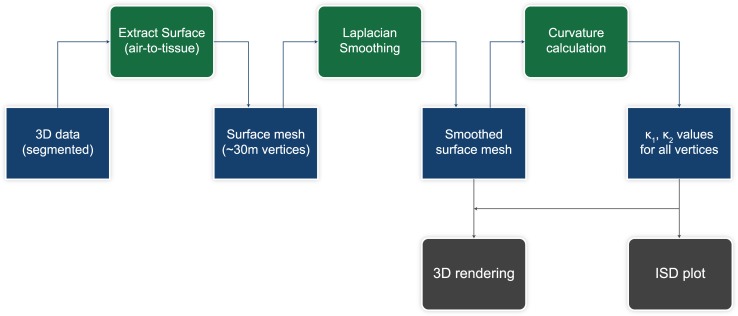
Curvature analysis flowchart.Processing flowchart for the curvature analysis. From the segmented volume the surface is first extracted [55], creating a surface mesh of about 30 million vertices. Subsequently Laplacian smoothing [56] is applied to reduce high-frequency noise, and curvature calculation is performed [53] to extract the two principal curvatures for all vertices. These are then used to create the ISD-plots and the 3D renderings.